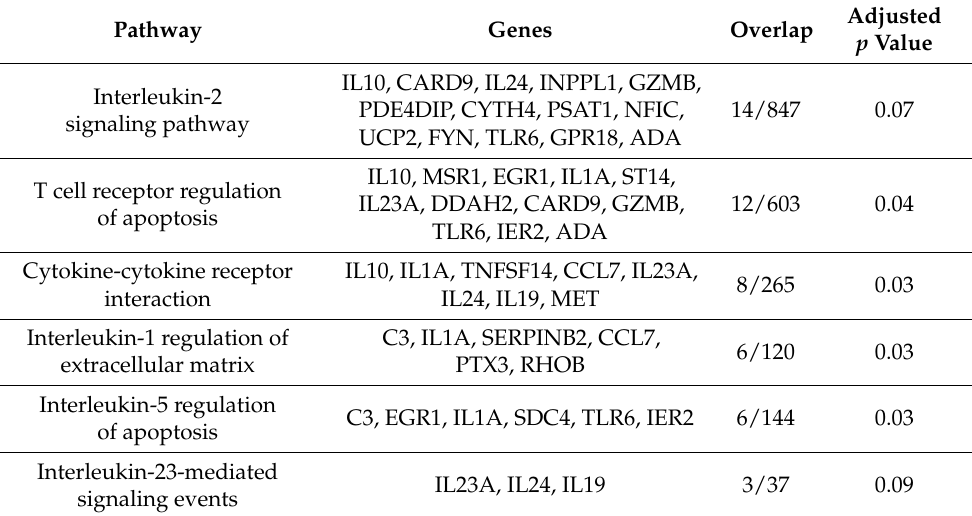
Table 1. Biological pathways enriched in genes (based on BioPlanet resource) with differential response of PBMCs to PM KRK treatment. The list of genes for the enrichment analysis included all genes with FDR corrected p < 0.05 from two-way ANOVA for the interaction (the list contained 131 genes, including genes presented in Figure 4). The top pathways (adjusted p < 0.1) are presented in this table. Full results are presented in Table S2.